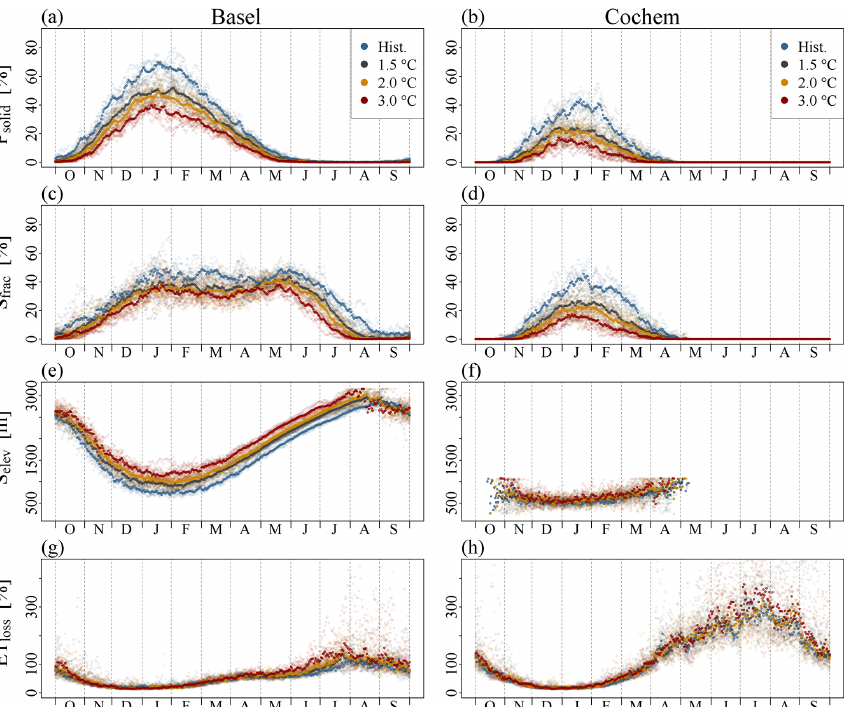
Figure 7. Mean annual cycles of the fraction of solid precipitation ( P solid ; a and b ), estimated importance of snowmelt compared to liquid precipitation ( S frac ; c and d ), average elevation of snowmelt ( S elev ; e and f ) and estimated evapotranspiration loss (ET loss ; g and h ) for sub-basins at Basel and Cochem under selected warming levels (14 GCM–RCP realisations reach 1.5 ◦ C, 13 reach 2 ◦ C and 8 reach 3 ◦ C